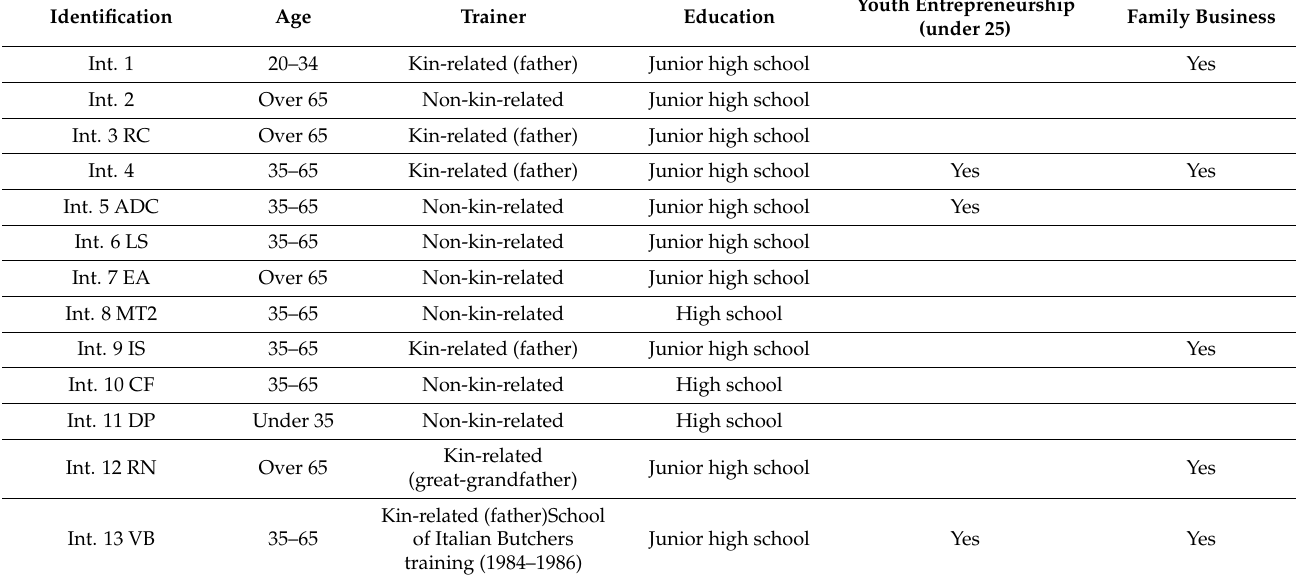
Table 1. Summary of the informants involved in the